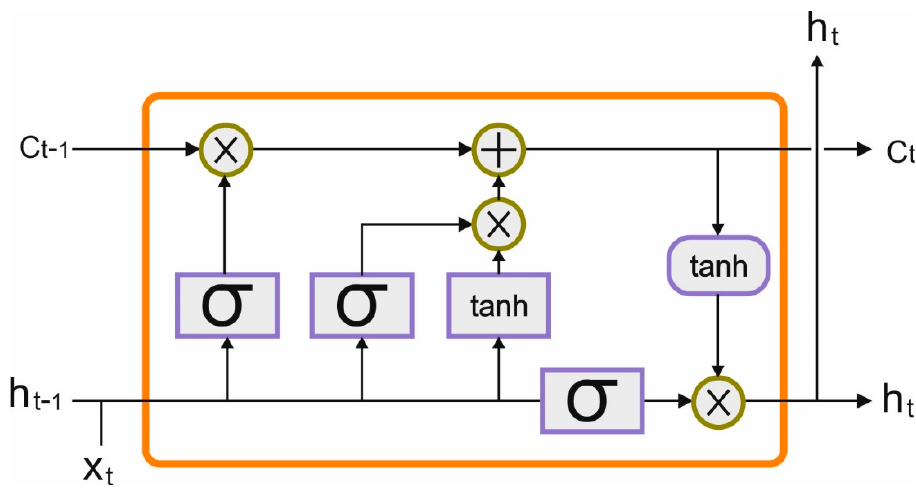
Figure 2. Architecture of LSTM.